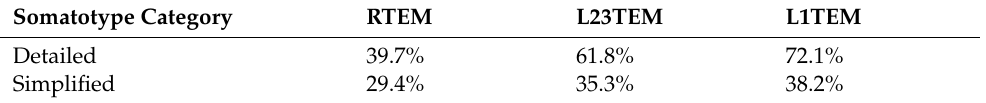
Table 1. Percentage of participants potentially mis-classified based on 95% CI’s.